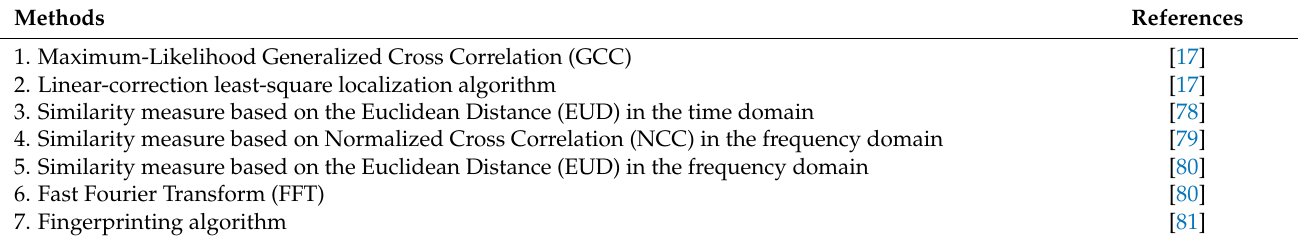
Table 7. Summary of methods for sound